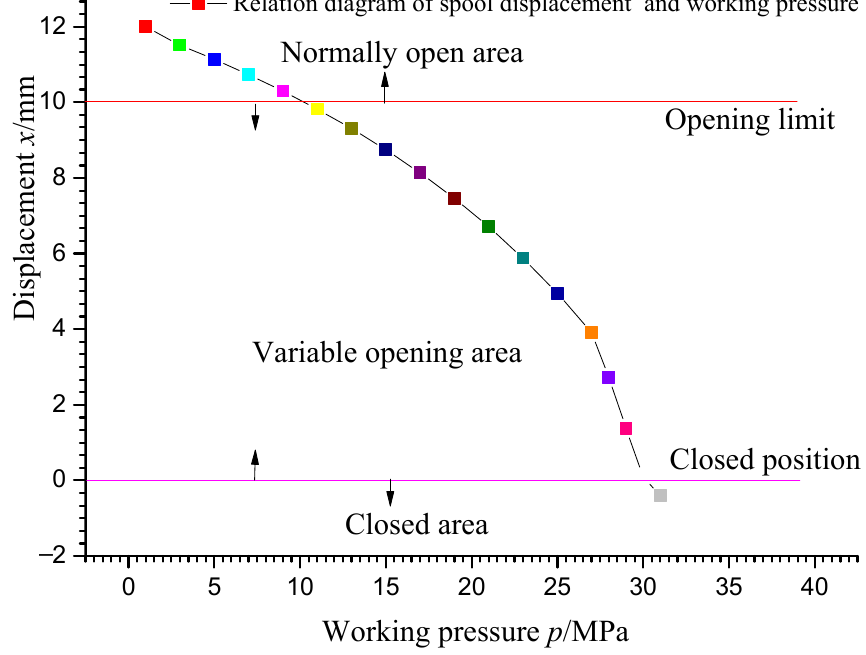
Figure 8. Relationship between working pressure and valve spool opening of the ordinary valve. In order to solve the above problems, the differential directional valve (also called the differential valve) was proposed to replace the ordinary valve. The main differences of the differential valve are shown in Figure 9. The return valve spool and the inlet valve spool move at the same time when they are in open position, and their equivalent driving area is much larger than the hydraulic action area of the working port. Thus, it can effectively ensure that the hydraulic driving force is much larger than the force in the closing direction and ensure that the opening of the valve spool remains unchanged.